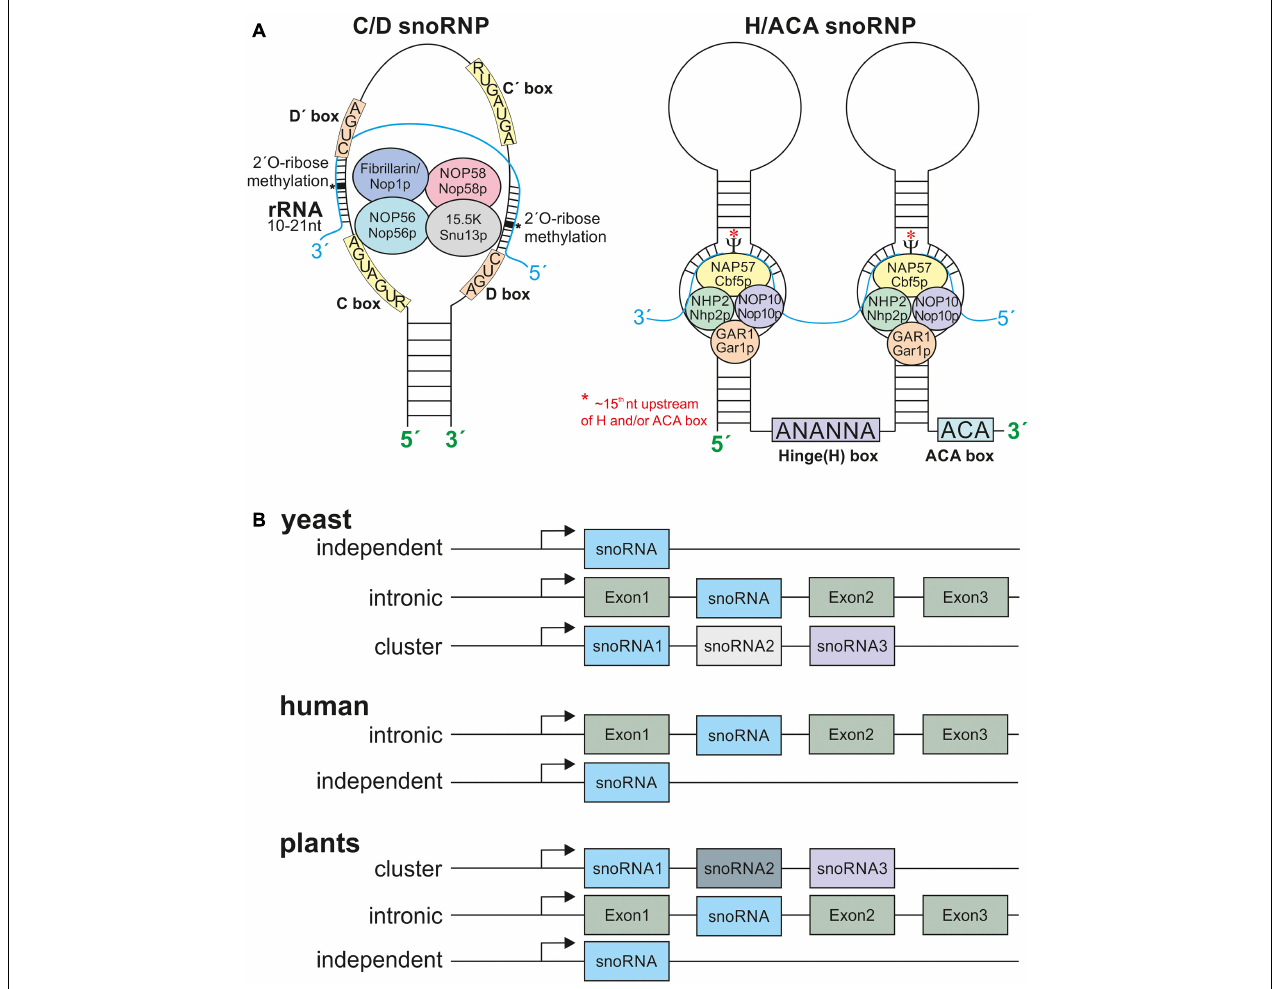
FIGURE 2 | The snoRNPs and snoRNA localization. (A) Depicted are the C/D box snoRNPs and H/ACA snoRNPs. The C/D box snoRNPs contain the conserved C (RUGAUGA) and D (CUGA) boxes and the two less conserved C’ and D’-boxes. The C/D box snoRNPs are composed of the methyltransferase fibrillarin/Nop1p, NOP56/Nop56p, Nop58/Nop58p, and 15.5K/Snu13p. The rRNA has a 10–21 nt long complementary site to the according snoRNA. The 2 (cid:48) -O-ribose-methylation takes place 5 nt downstream of the D or D’ box (asterisks). The H/ACA box snoRNPs are composed of at least one stem loop. The Hinge Box (ANANNA) is located between two stem loops and the ACA box at the 3 (cid:48) end of the snoRNA. The pseudouridine synthase NAP57/Cbf5p is modifying approx. the 15th nucleotide (asterisks) of the rRNA upstream of the H and or ACA box, further the proteins NHP2/Nhp2p, Nop10/Nop10p, and GAR1/Gar1p are required. (B) The snoRNA gene organization in different eukaryotes. Yeast snoRNAs are mainly localized in independent regions and lesser in intronic and polycistronic (cluster) regions. The human snoRNA gene organization is mostly intronic with few independent genes and plant snoRNAs are mostly located within clusters of many snoRNAs. Only very few examples for intronic and independent gene organization are known. For references see main